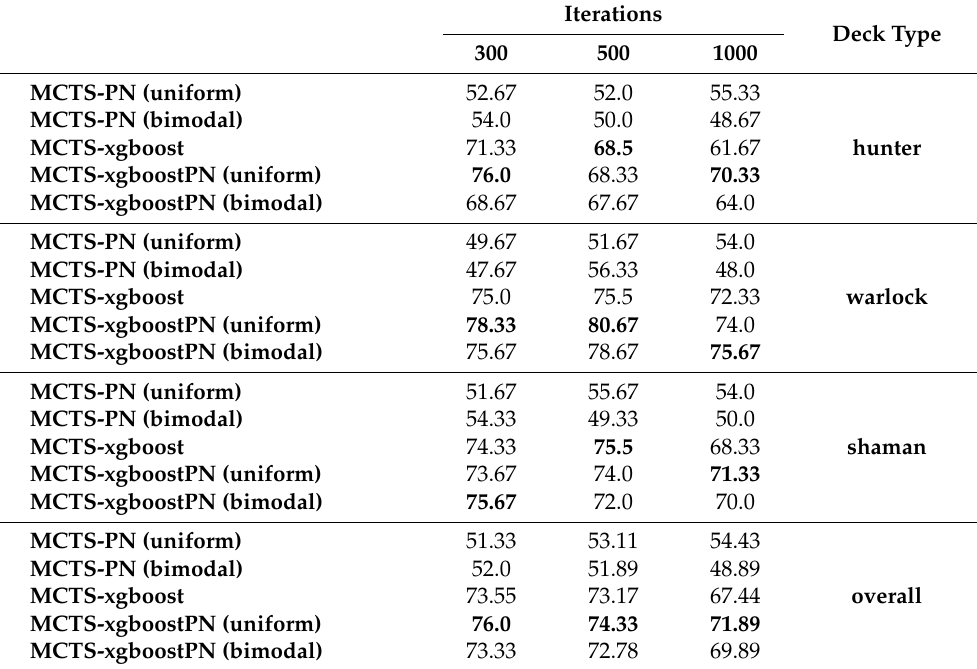
Table 2. Win rate per number of iterations against MCTS (the highest win rate per deck type and number of iterations is indicated in